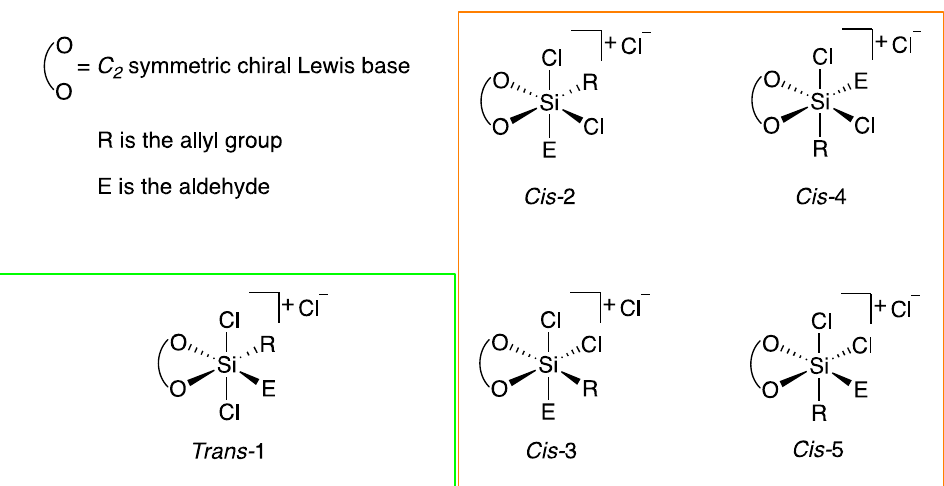
Figure 1. The five possible arrangements of the ligands and chlorine atoms around a hexavalent silicon atom when a C 2 -symmetric Lewis base (such as structures 5 – 9 in Figure 2) is used. See also Section S2 in the Supporting Information for a visual representation.